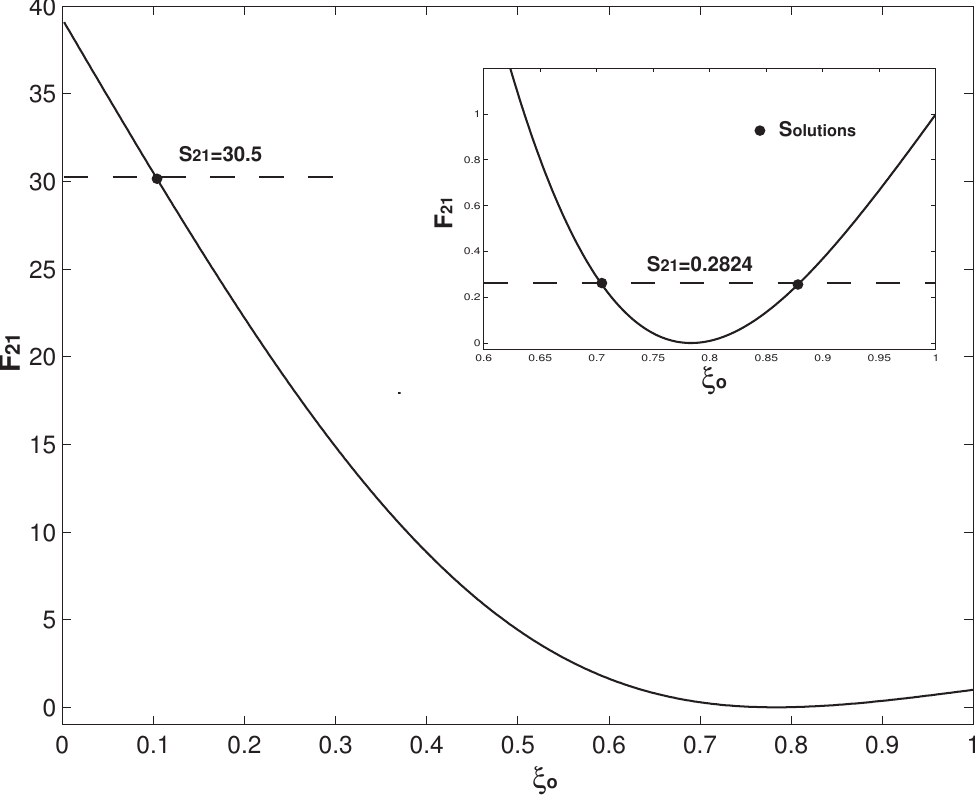
as a function of ξ 21 = 0 . 2824 21